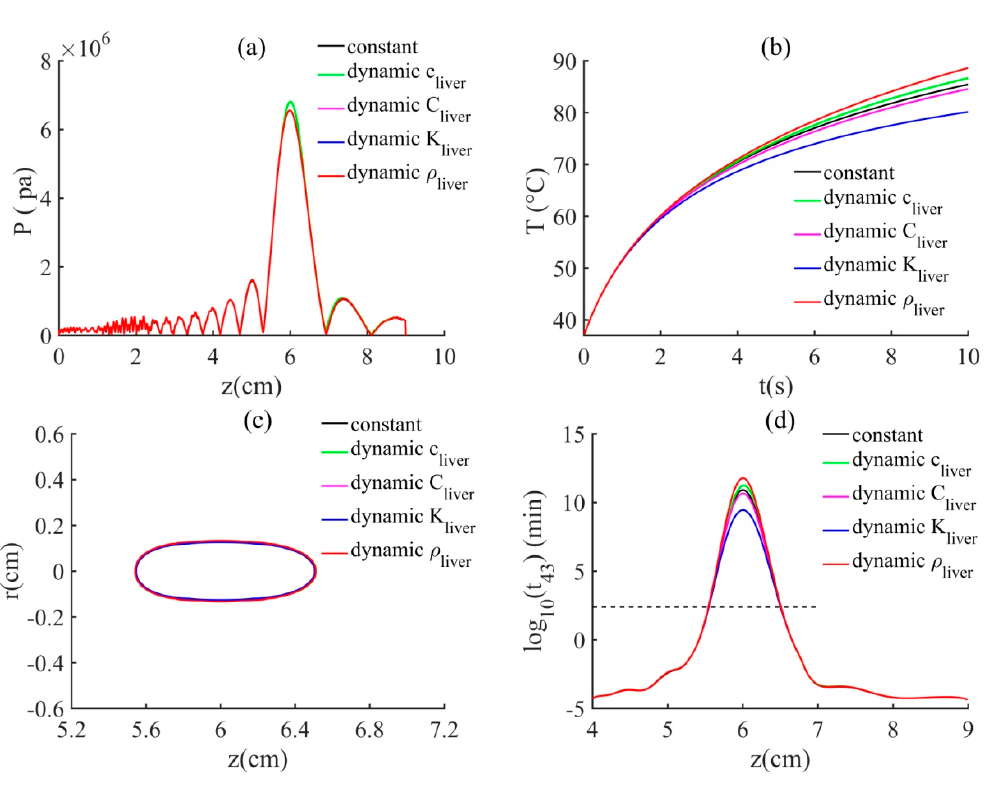
Figure 7. The effects of dynamic sound speed, dynamic specific heat capacity, dynamic thermal conductivity, and dynamic density on: ( a ) p and ( b ) T at the ultrasonic focus, ( c ) the thermal damage zone, and ( d ) t 43 at t = 10 s.